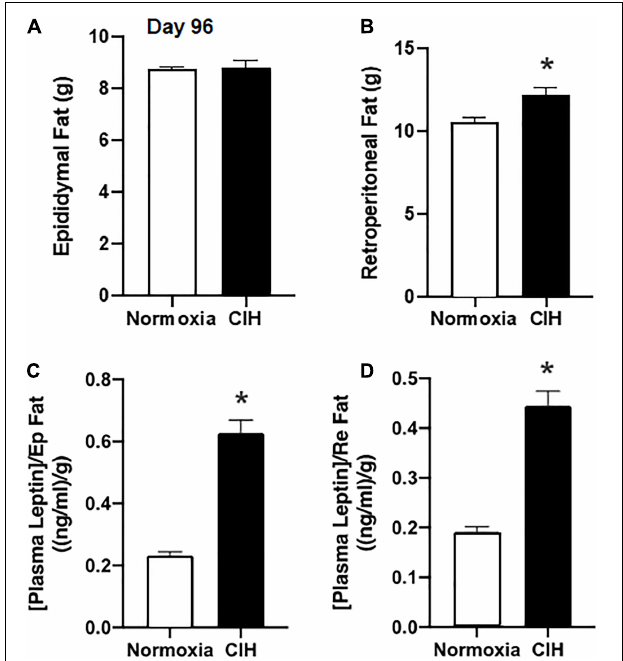
FIGURE 4 | Bar charts summarize epididymal (A) and retroperitoneal (B) fat pad mass after 96 days of CIH or normoxia exposure. Note that weight change in retroperitoneal (Re) adipose tissue mass was altered after CIH, but that of epididymal (Ep) adipose tissue mass was not altered. (C,D) Show plasma leptin levels normalized for Ep and Re adipose tissue mass. Note that in both cases basal plasma leptin levels are elevated when fat pad mass is taken into account. n = 16 for each group. Data are shown as mean ± standard error. * p < 0.05.